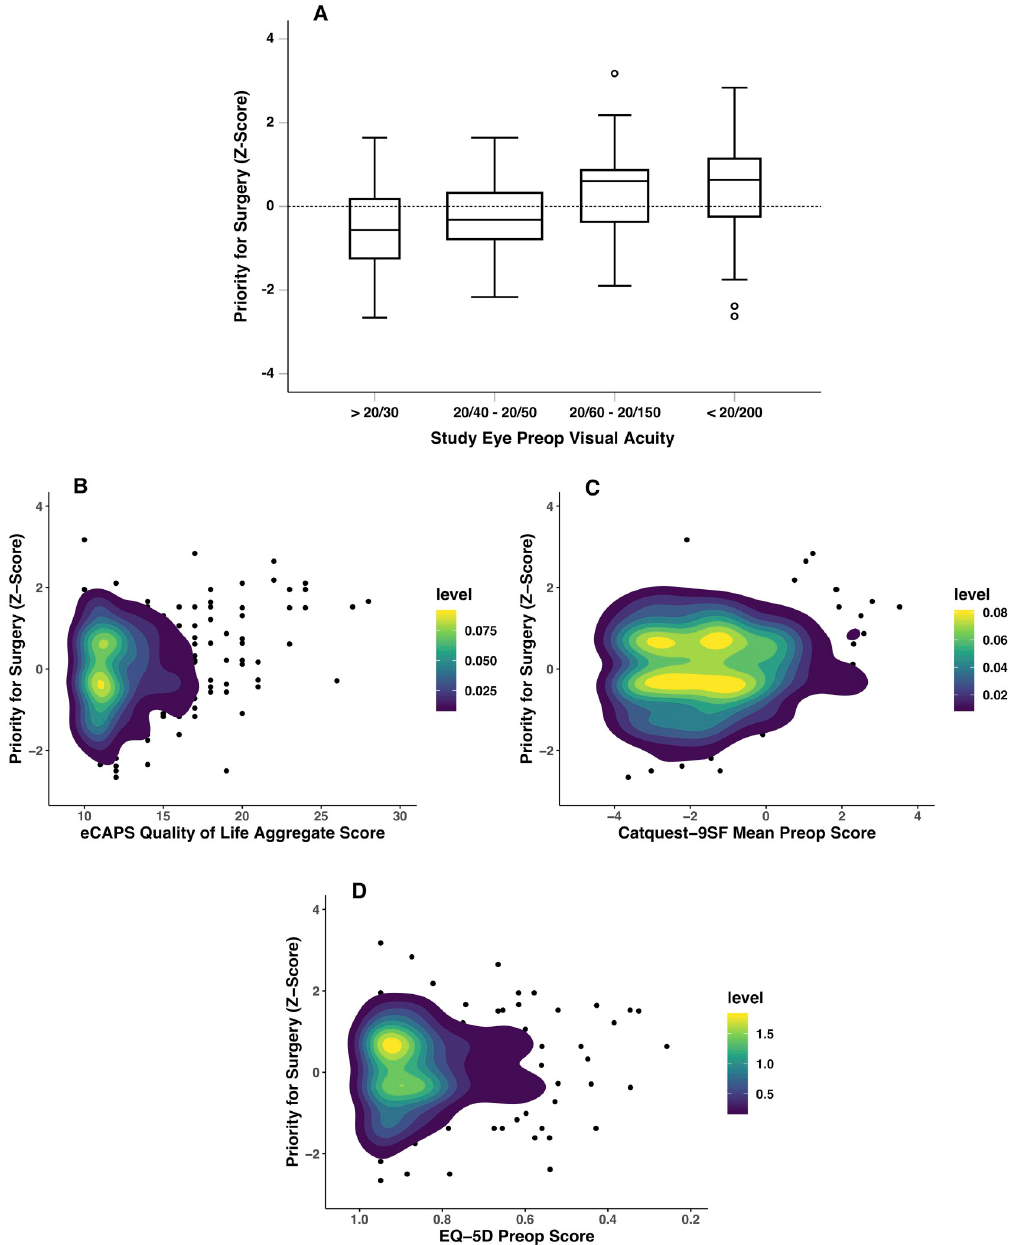
Fig 4. Boxplot of preop visual acuity and priority ranking with box and error bar widths scaled based on count. (A). 2D density plots of eCAPS QoL aggregate score (B), Catquest-9SF mean preop score (C), and EQ-5D score (D) versus priority for surgery. Each x-axis has been scaled to show increasing disability towards the right. Level bar guide defines the density of data for each of the pixels contained in the